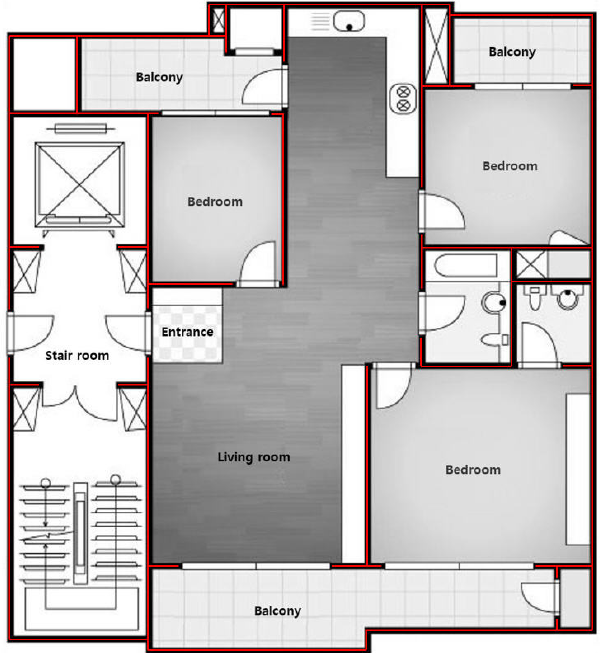
Figure 3. Restoring the wall center line (red pixels) of a 2D plan image